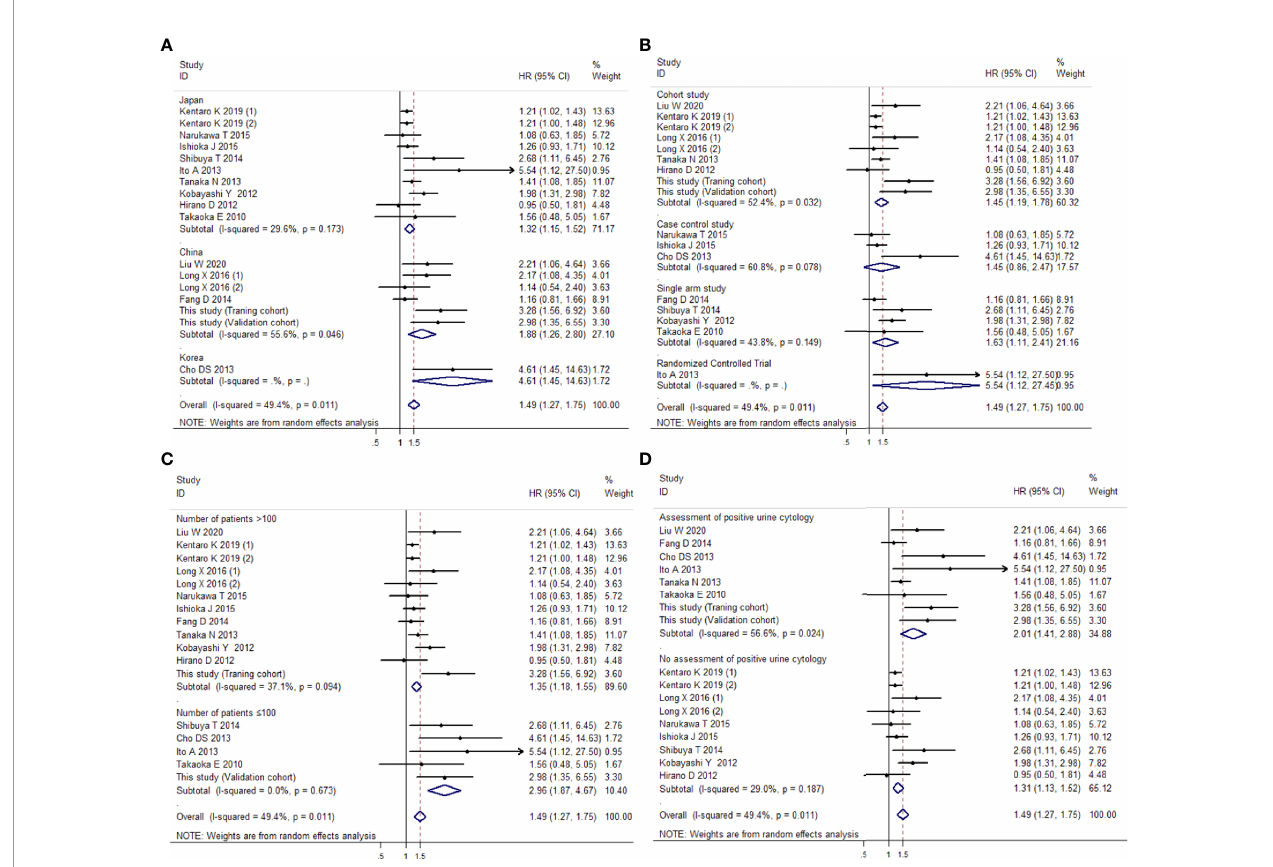
FIGURE 11 | Forest plots showing the risk of intravesical recurrence in UUT-UC patients with preoperative positive urine cytology by subgroup analysis of the (A) region, (B) study types, (C) sample size, and (D) assessment of urine cytology. Squares in each trial indicate the hazard ratios, the horizontal line that traverses the square indicates the 95% con fi dence interval (CI), and diamonds indicate the estimated combined effect. According to the heterogeneity analysis, the Mantel – Haenszel random-effects model was selected.